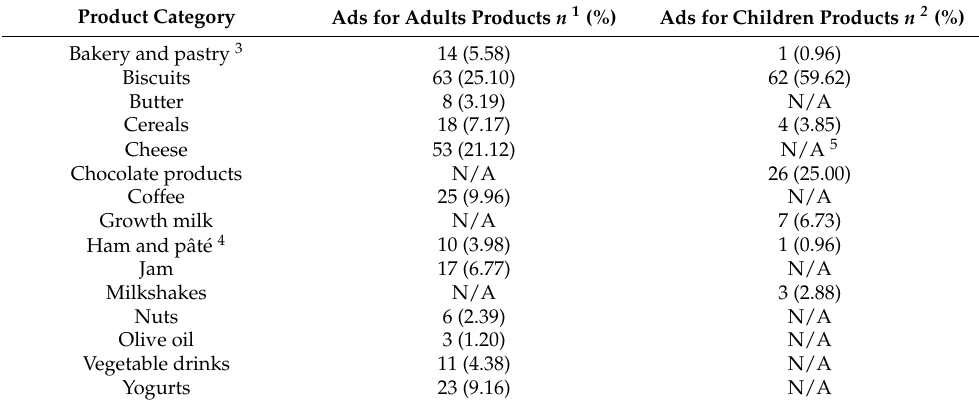
Table 1. Distribution of the adverts by category and consumer